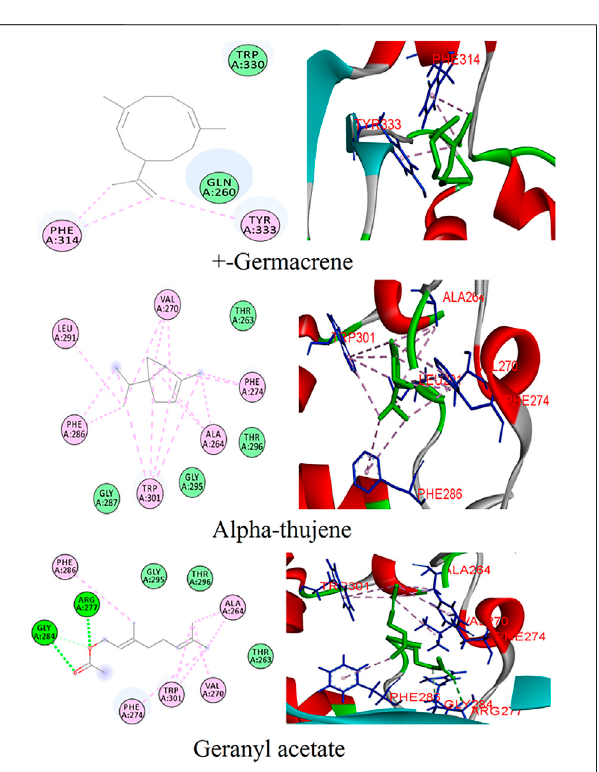
FIGURE 2 | Binding patterns of the top phytoligands from Coriandrum sativum against the N